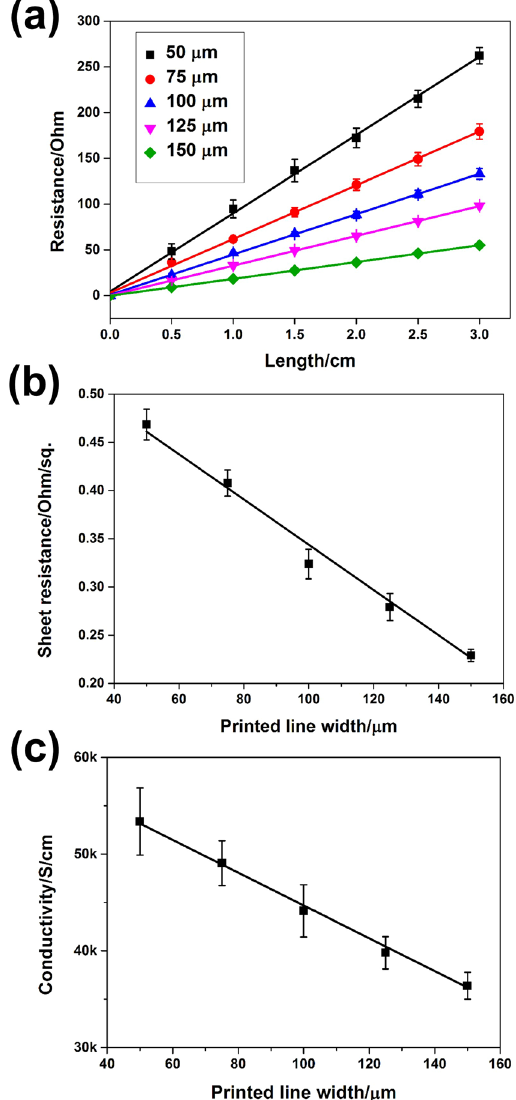
Figure 5. ( a ) Measured resistance of the gravure-printed AgNW lines at different length and with various line widths. ( b ) Calculated sheet resistance of the gravure-printed AgNW lines with various line widths. ( c ) Calculated conductivity of the gravure-printed AgNW lines with various line widths. At least three samples were tested for each line